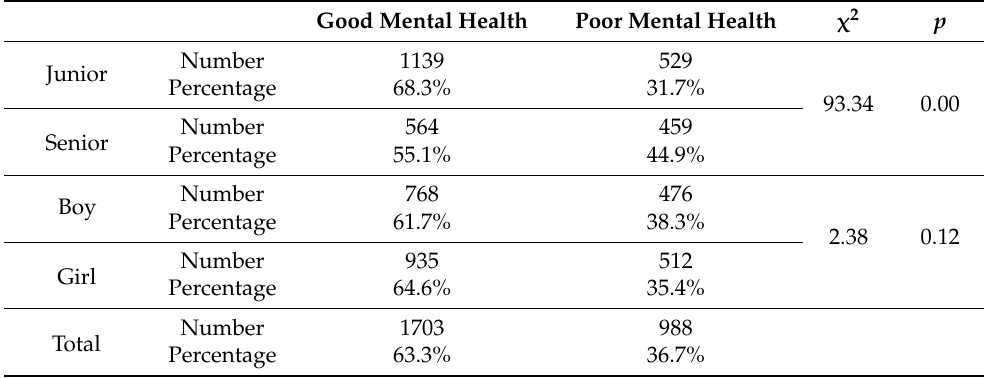
Table 2. Adolescents’ mental health during the